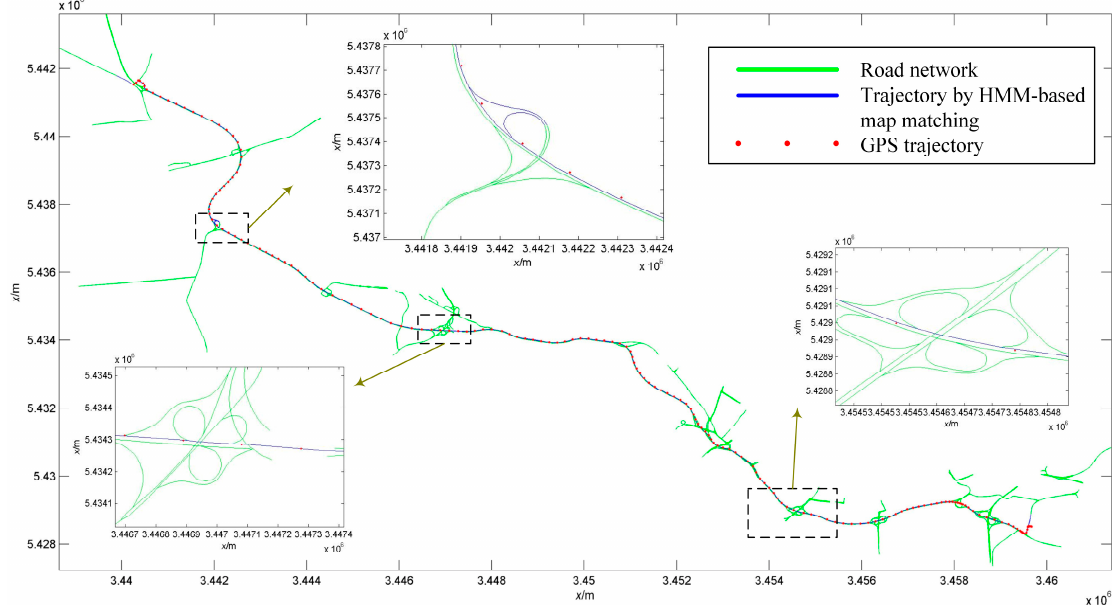
Figure 6. Details of the Viterbi path in the HMM-based map-matching method.